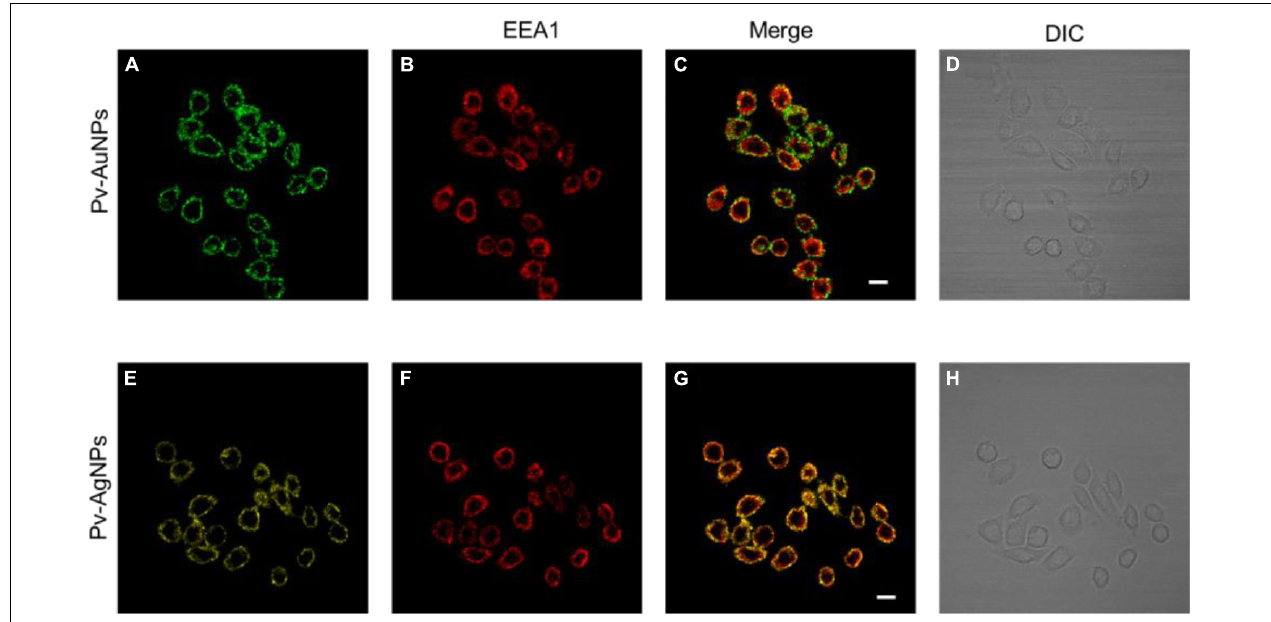
FIGURE 6 | Internalization of Pv-PNPs in A549 cells. (A–D) Internalization of Pv-AuNPs (A) in A549 cells showing their presence in early endosomes (B) . Colocalization of Pv-AuNPs and EEA1 is shown by the overlay image (C) . (D) DIC image of A549 cells treated with Pv-AuPNPS. (E–H) Internalization of Pv-AgNPs (A) in A549 cells, and their localization in early endosomes (F) . Extensive colocalization of Pv-AgNPs in early endosomes is shown by the overlay image of Pv-AgNPs and EEA1 (G) . (D) DIC image of A549 cells treated with Pv-AgNPs. Scale bar indicates 20 µ